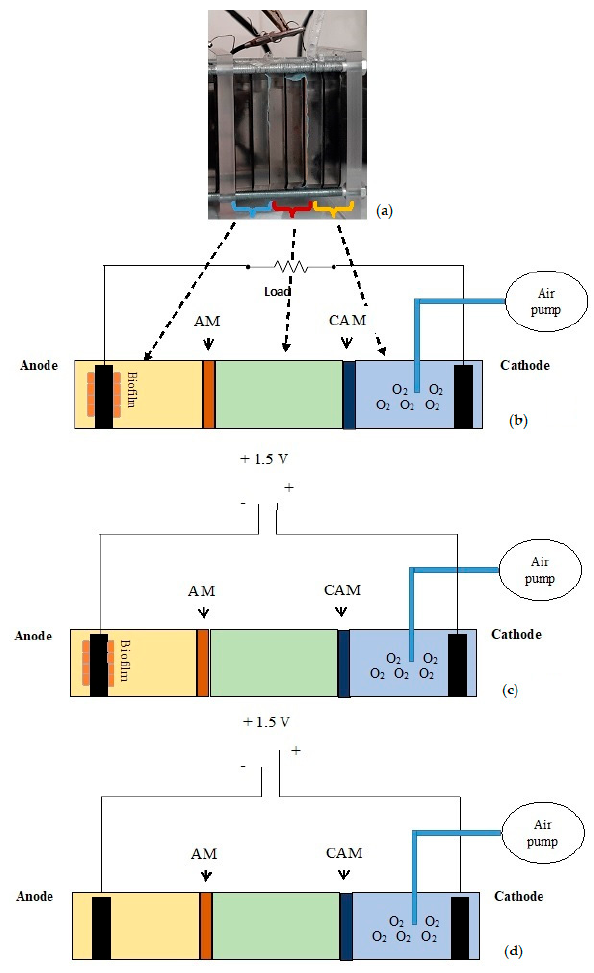
Figure 2. MDCs’ experimental scheme. ( a ) Image of lab-scale MDCs; ( b ) MDC with mature biofilm, no external source of potential connected; ( c ) MDC with mature biofilm, 1.5-V external voltage ap- plied; ( d ) MDC with no microbial inoculum (negative control). AM: anions-exchanging membrane; CAM: cations-exchanging membrane; Load: external load.